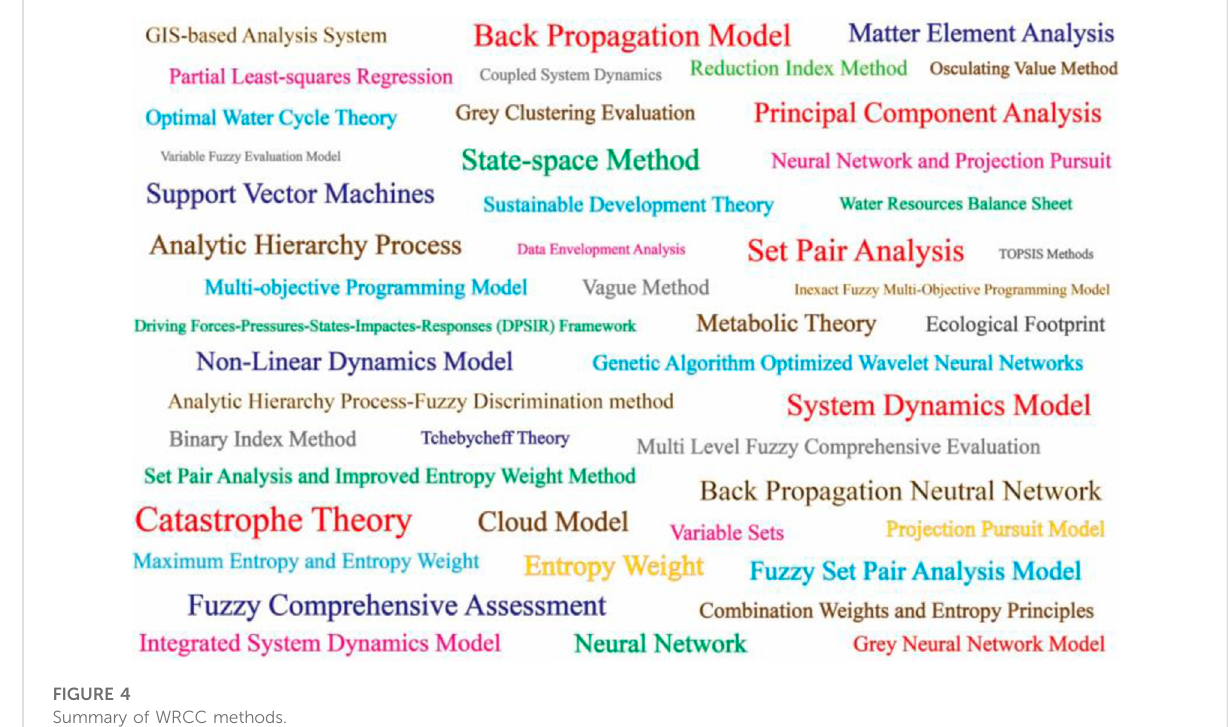
FIGURE 4 Summary of WRCC